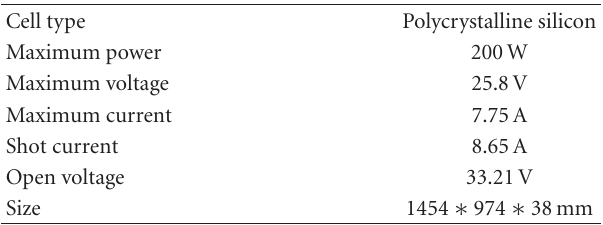
Table 1: PV module specifications.